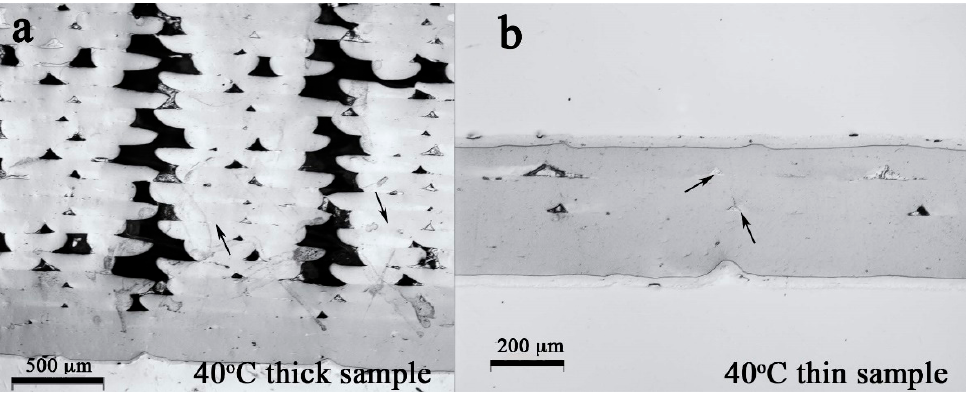
Figure 2. The cross section of the ( a ) thick and ( b ) thin PLA samples printed on the build-platform heated at 40 °C. The bar in ( a ) is 500 μ m. The bar in ( b ) is 200 μ m.